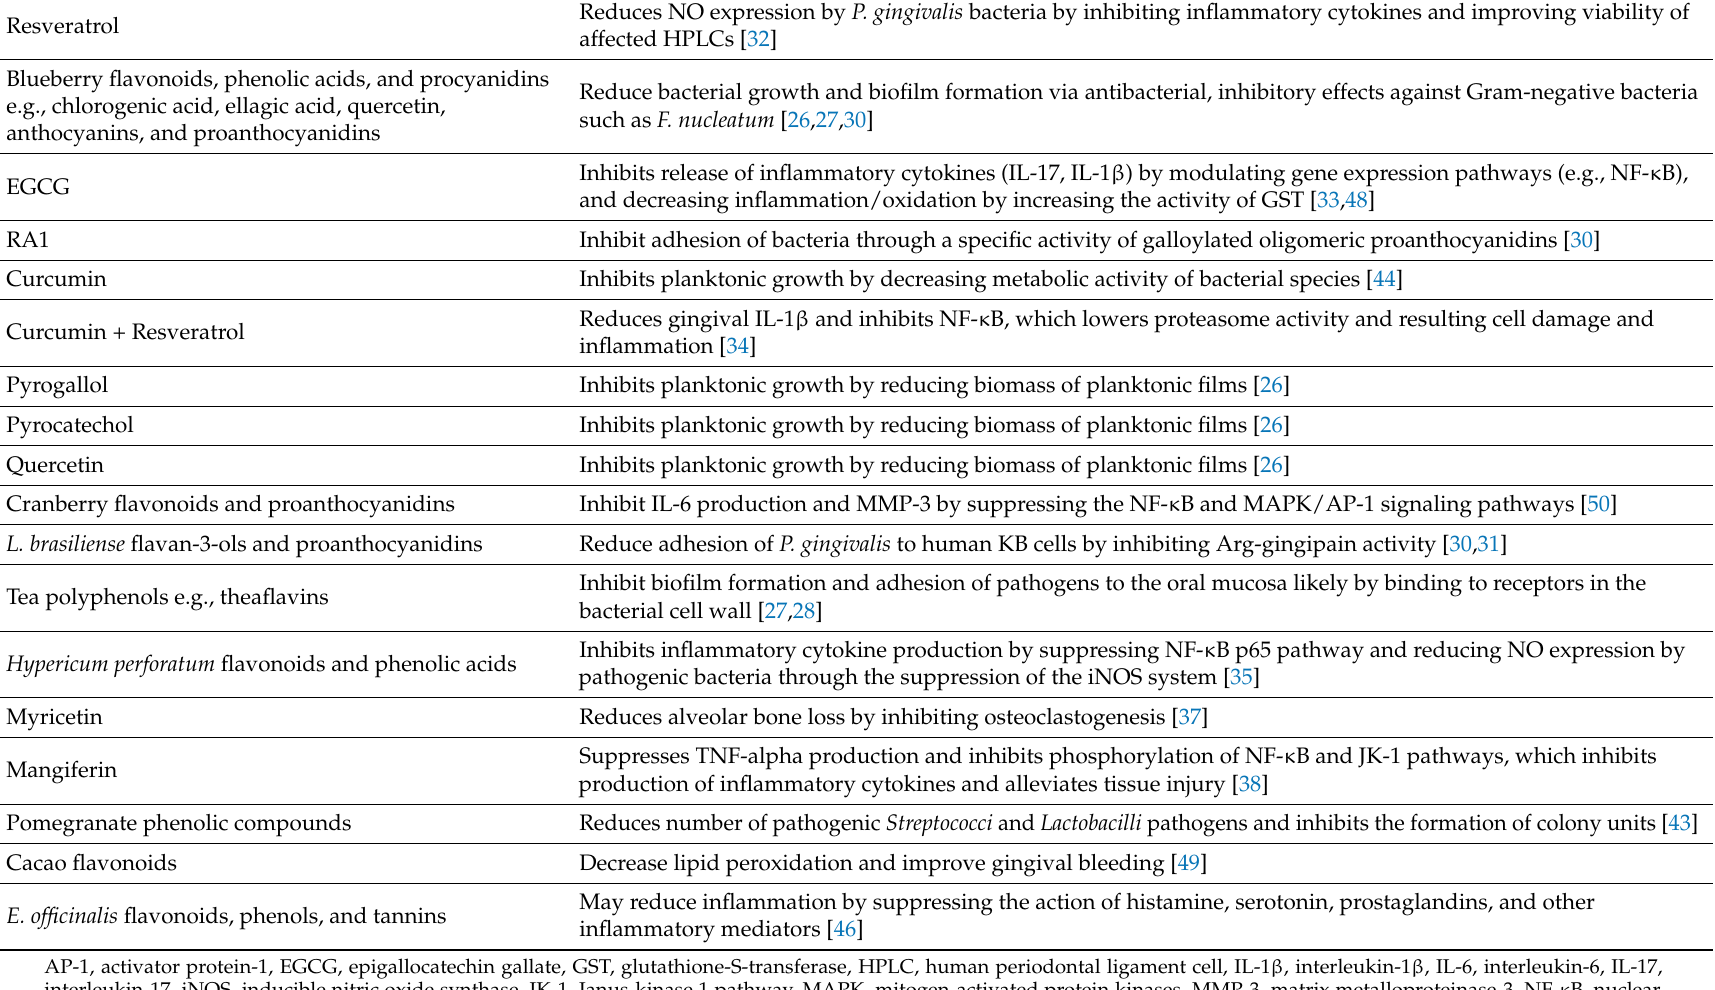
Table 4. Summary of mechanisms of action of dietary polyphenols in